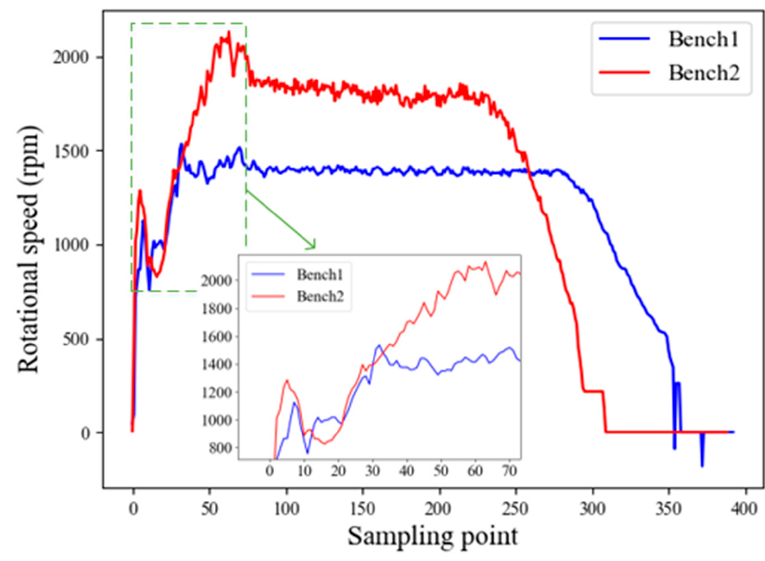
Figure 2. Comparison of rotational speed curves between different benches.